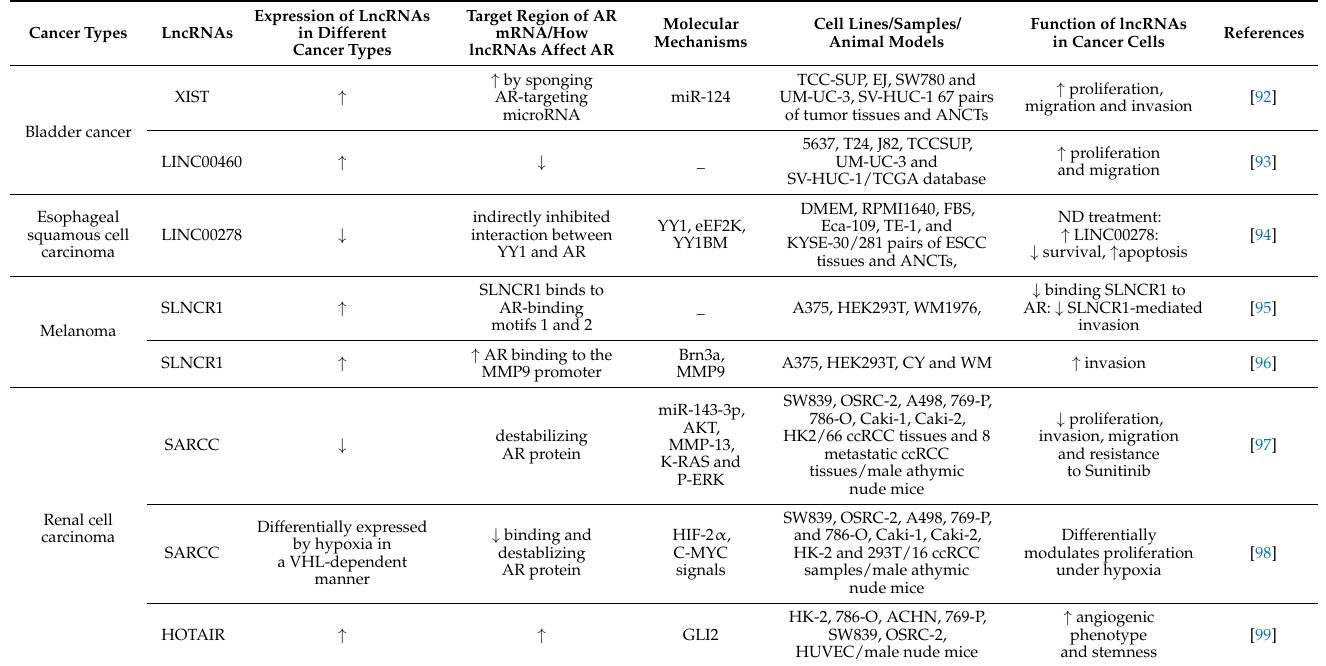
Table 4. Effects of lncRNAs on AR in different cancer types (ND: nutrient deprivation, ccRCC: clear cell renal cell carcinoma, ↓ : decrease in, ↑ : increase